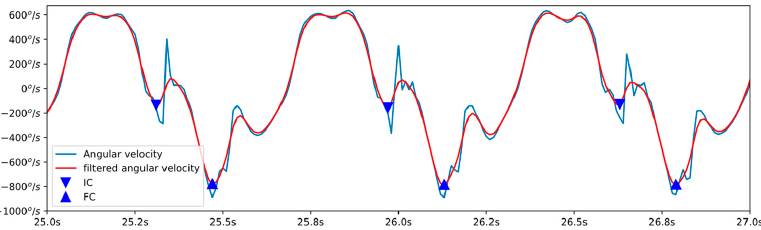
Figure 5. Blue line: angular velocity in the mid-lateral axis obtained from the foot-mounted inertial sensor. Red line: low pass filtered angular velocity. IC and FC events are indicated by a downward triangle and an upward triangle, respectively.